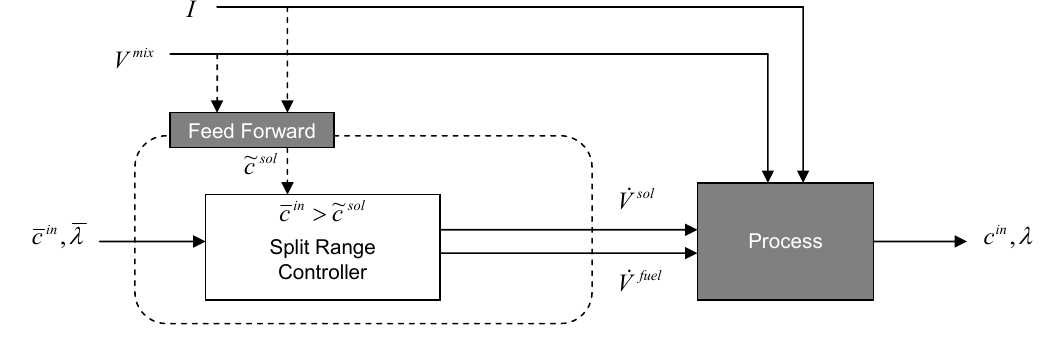
Figure 4. The block diagram of the MIMO feedforward concentration and λ controller in the two-mixer